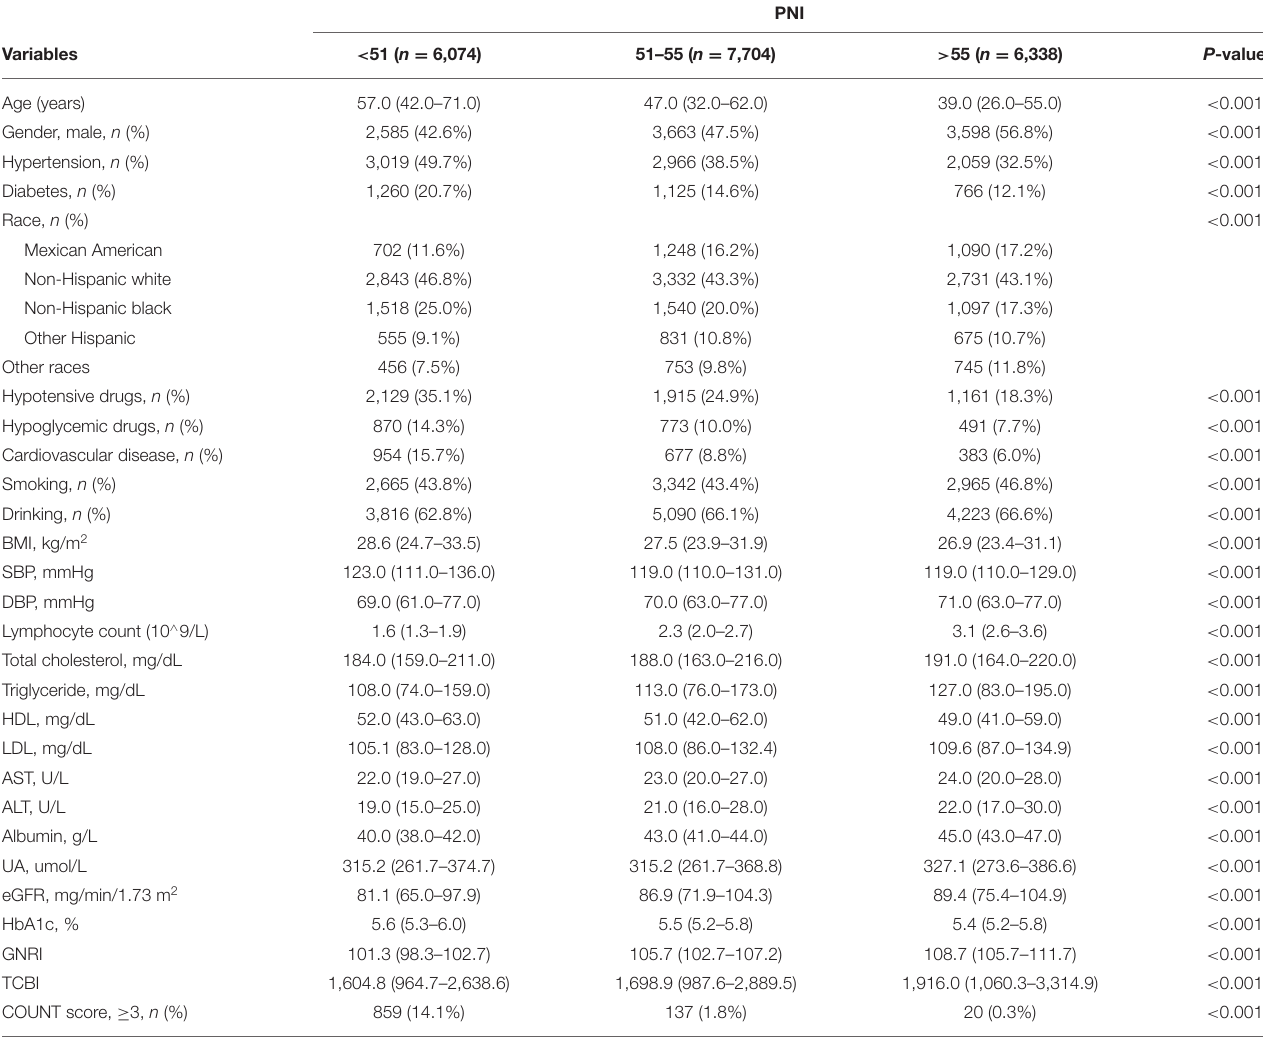
TABLE 1 | Baseline